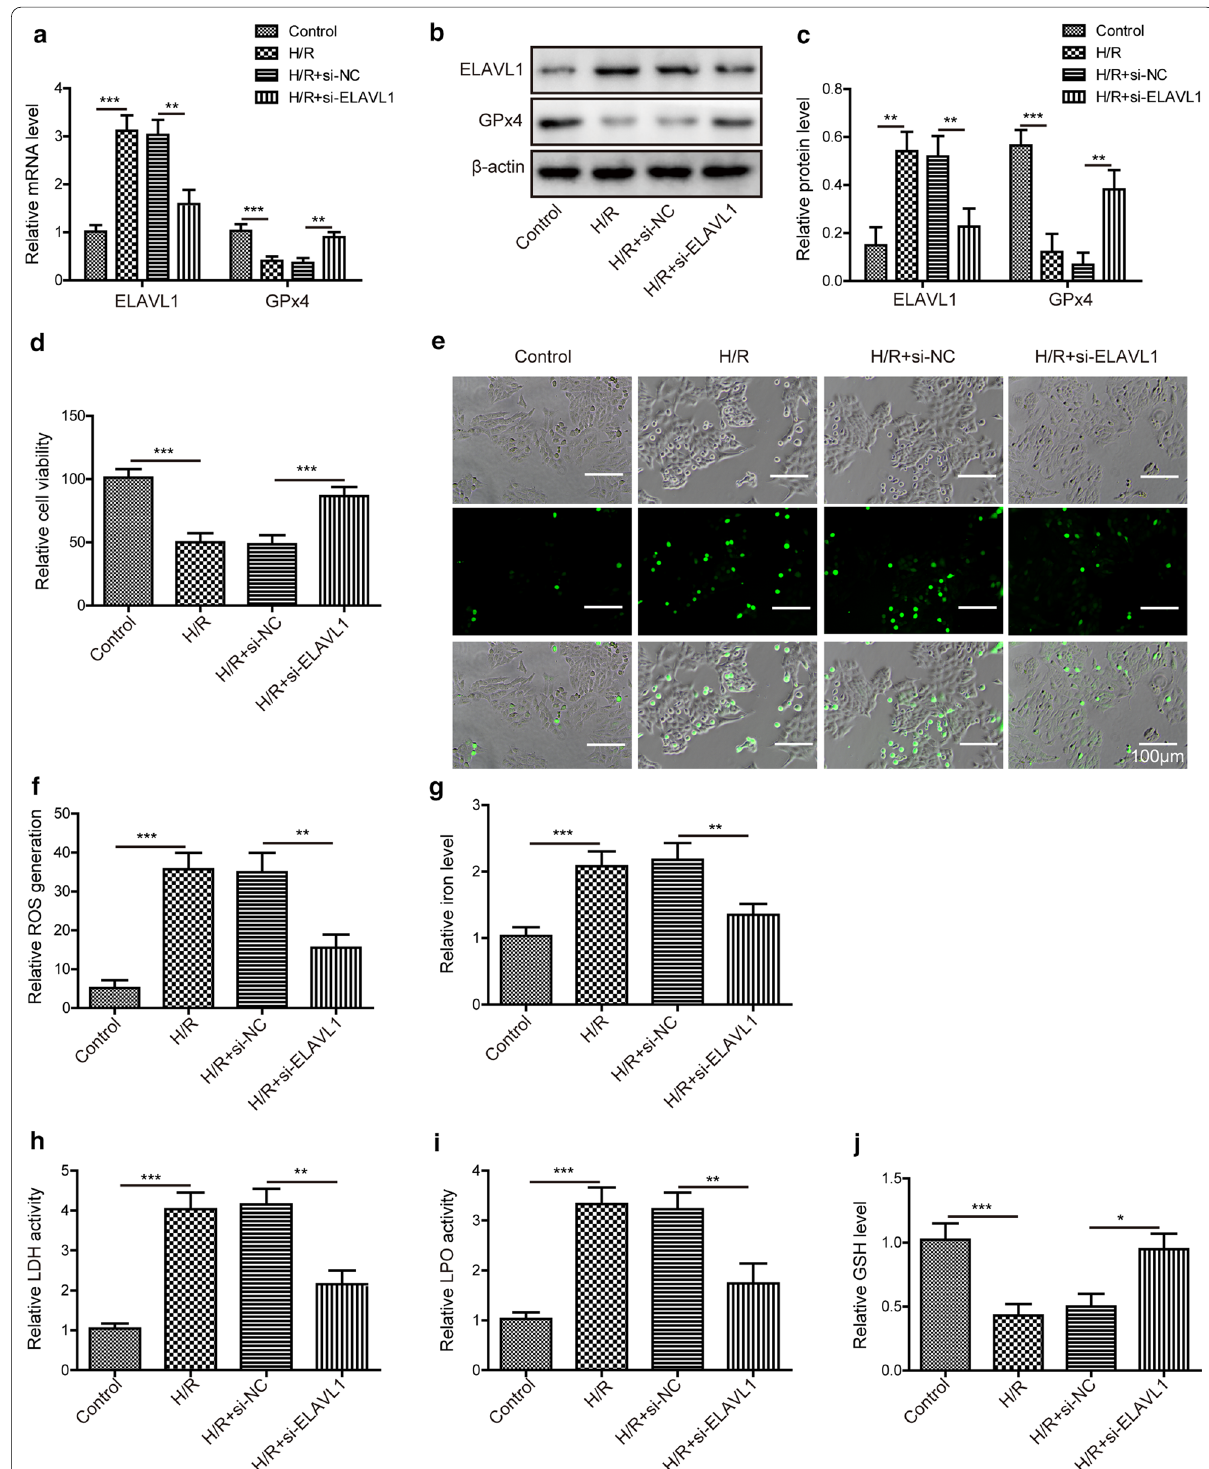
Fig. 2 Knockdown of ELAVL1 suppresses ferroptosis and H/R injury. Myocardial cells were transfected with si‑ELAVL1 or si‑NC and then subjected to H/R. a Relative mRNA levels of ELAVL1 and GPx4 in transfected myocardial cells following H/R exposure. b , c Relative protein levels of ELAVL1 and GPx4 in transfected myocardial cells following H/R exposure. d CCK8 assay to assess viability of transfected cells upon H/R exposure. e , f Relative cellular ROS levels were measured in each group of cells. Relative cellular iron level ( g ), LDH activity ( h ), LPO level ( i ) and GSH level ( j ) in each group were detected respectively. The results were presented as the mean SD. n 3; * P < 0.05, ** P < 0.01, *** P < ± =